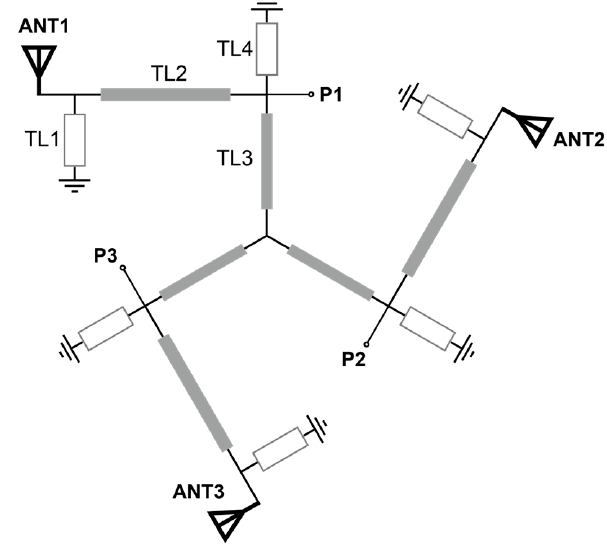
Figure 7. Diagram of the array cascaded with the DMN. The admittance matrix at the reference plane t 1 are calculated as follows: